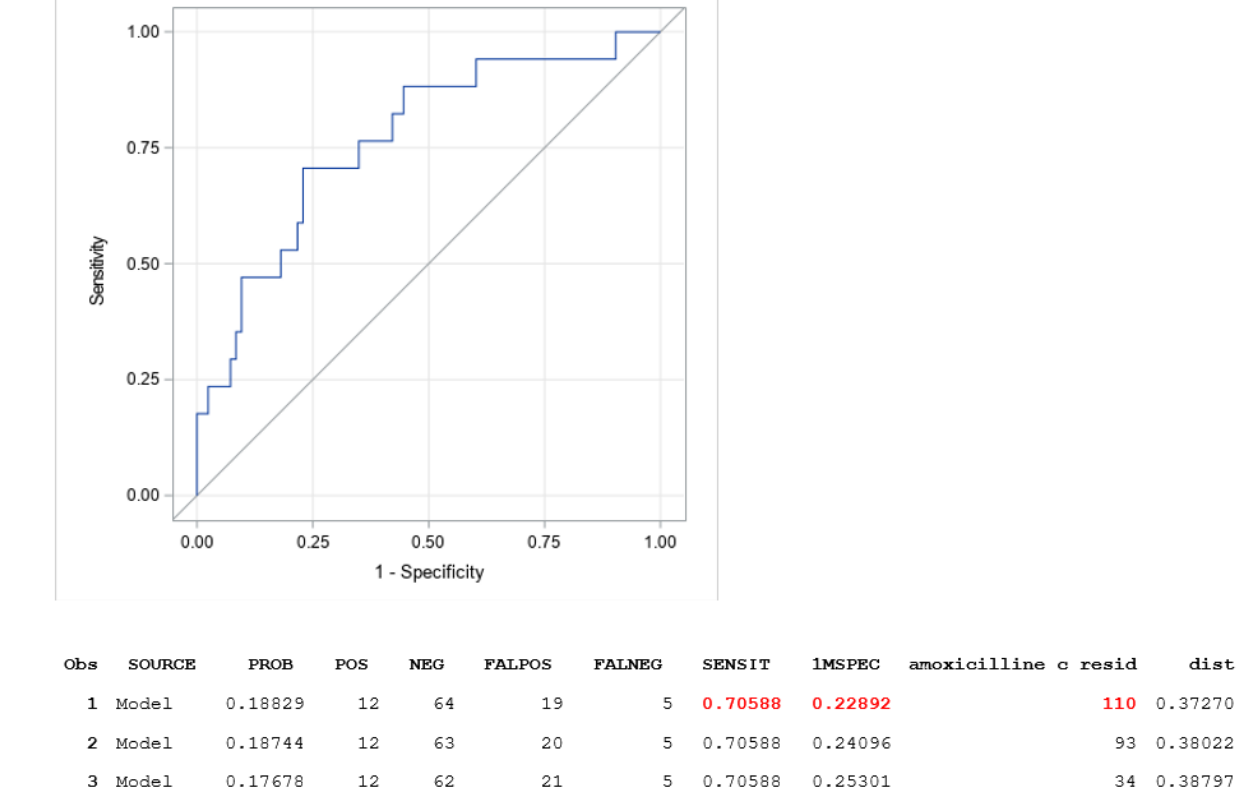
Figure 4. Receiver-operating characteristic curve of amoxicillin plasma concentration in relation to its attributable neurotoxicity or not after adjustement of the potential confounding factors: age, sex, weight, AMX daily dose, infection type, eGFR.